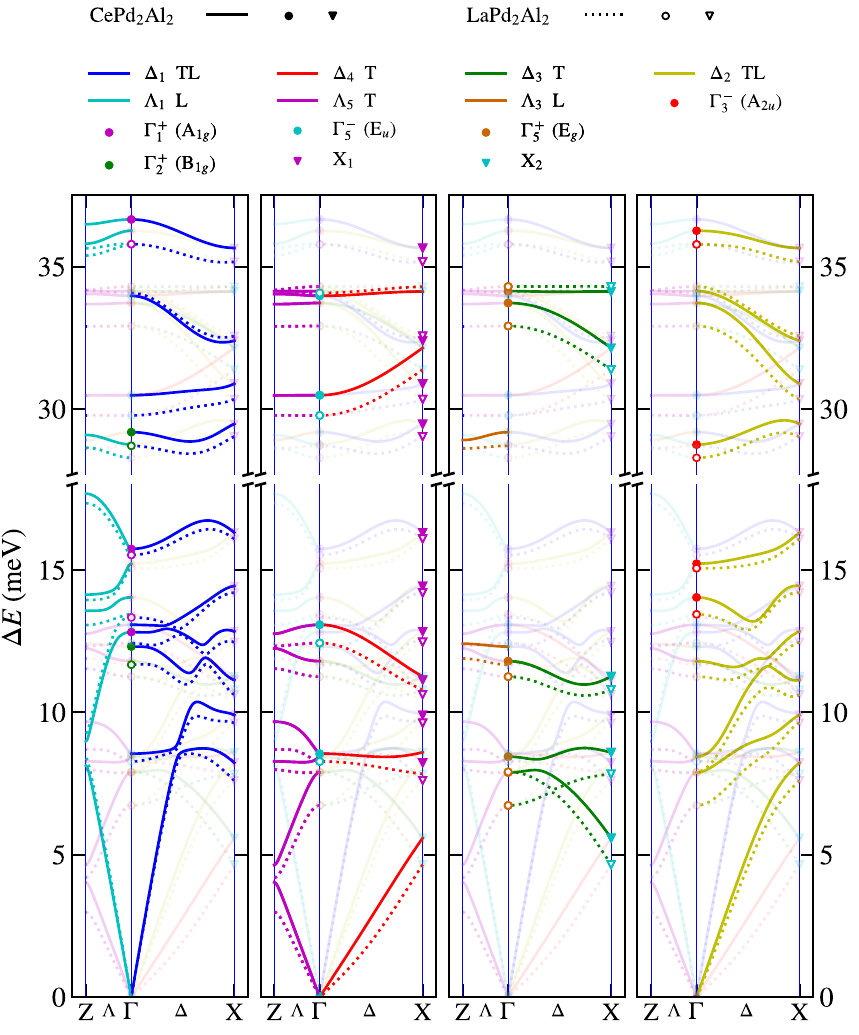
Figure 2. Symmetry analysis of 30 calculated phonon modes for (Ce,La)Pd 2 Al 2 , considering degeneracy. The abbreviation TL signifies the mixed character of longitudinal and transversal polarisation and T signifies a pure transversal character. Each panel highlight modes and branches with selective symmetry, the corresponding labels are above each panel. For details see chapter Results–Phonon dispersion curves in (Ce,La)Pd 2 Al 2